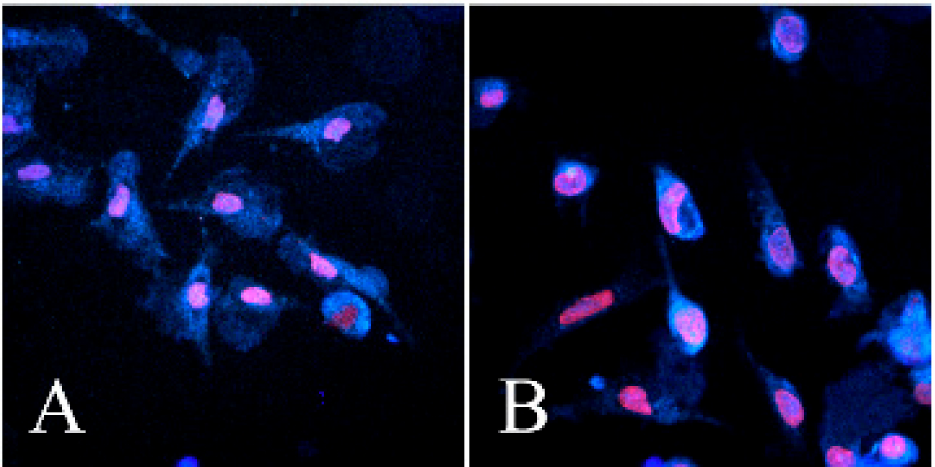
Figure 6. Confocal image 24 h after photodynamic therapy (PDT) treatment (after irradiation with light dose 30 J / cm 2 of 740 nm + light dose 1 J / cm 2 of 414 nm). ( A )—TMPyP and ( B )—GO / TMPyP nanocarrier at concentration of 25 µ M. Magnification is 40 × .